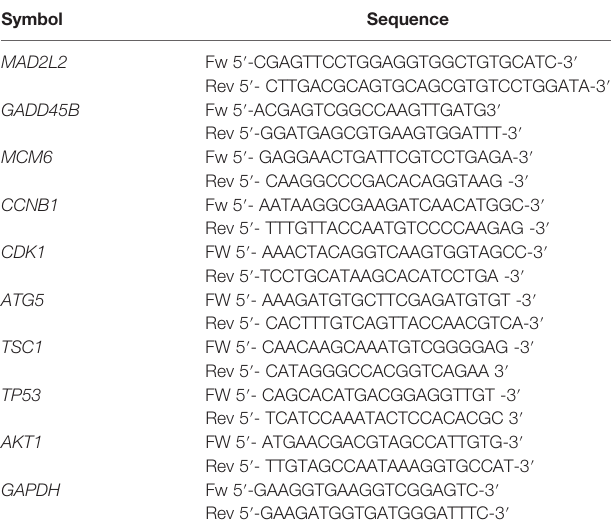
TABLE 3 | Primer Sequences used for RT-qPCR. Symbol